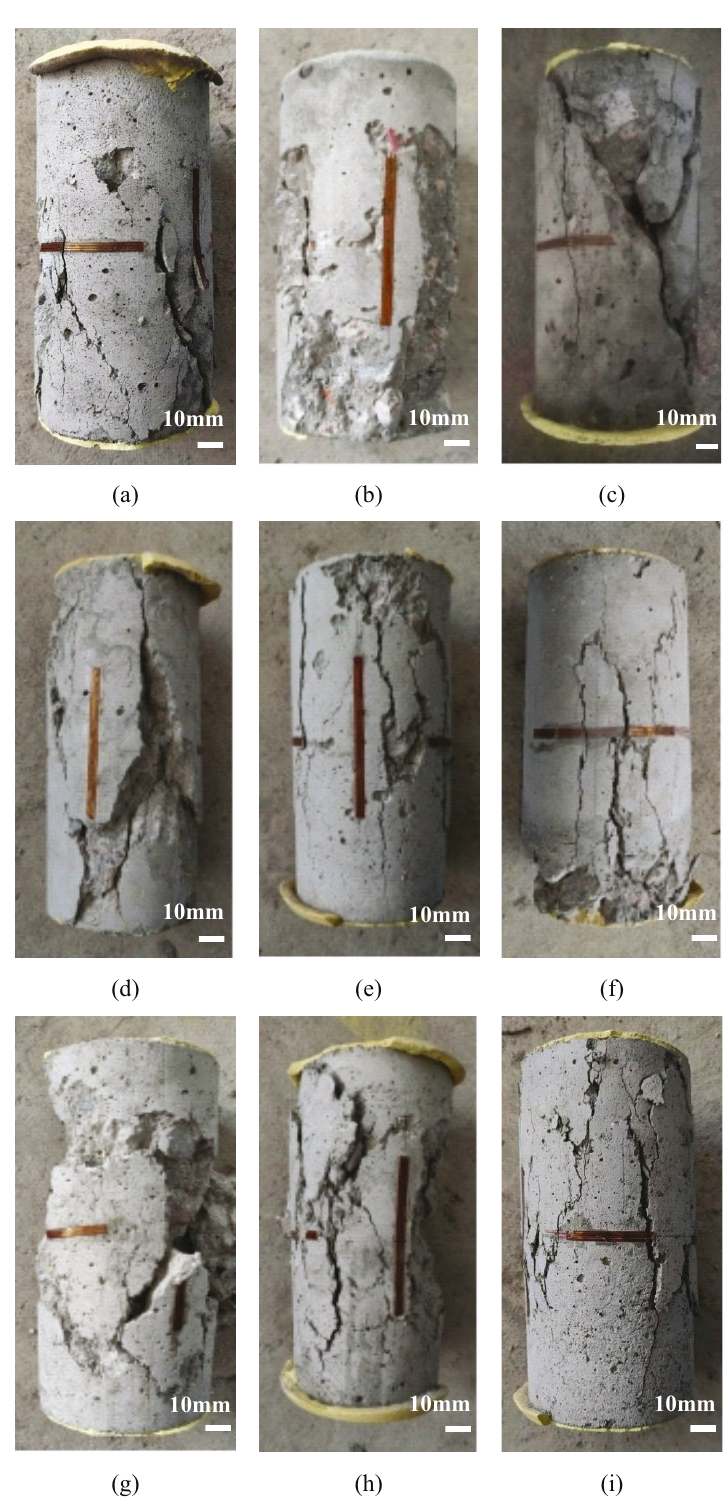
Figure 20: Failure patterns of RRAC. ( a ) 0.3 – 5% - 6 - RM, ( b ) 0.3 – 10% - 60 - AM, ( c ) 0.3 – 15% - M - RM + AM, ( d ) 0.4 – 5% - 60 - RM + AM, ( e ) 0.4 – 10% - M - RM, ( f ) 0.4 – 15% - 6 - AM, ( g ) 0.5 – 5% - M - AM, ( h ) 0.5 – 10% - 6 - RM + AM, and ( i ) 0.5 – 15% - 60 -